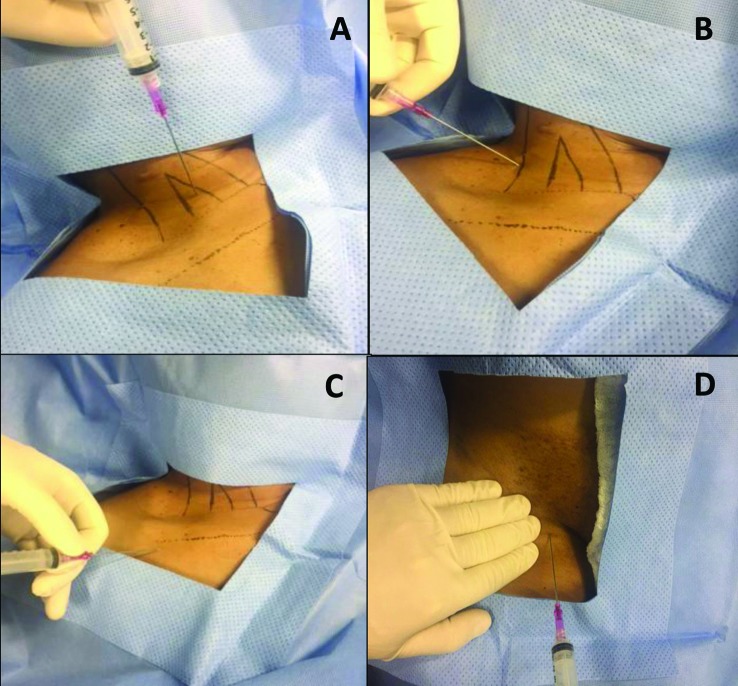
Deep vein puncture techniques most commonly used for insertion of venous catheters. (A) Puncture anterior of the internal jugular vein (IJV). Entry between the bellies of the sternocleidomastoid muscle, with the needle angled at 45º in the direction of the ipsilateral nipple; (B) Puncture posterior to the IJV. Needle inserted in the medial direction, below the clavicular branch of the sternocleidomastoid muscle; (C) Infraclavicular puncture of the subclavian vein, with entry between the medial and lateral thirds of the clavicle; (D) Puncture of the femoral vein medial of the site where the femoral arterial pulse is palpated.